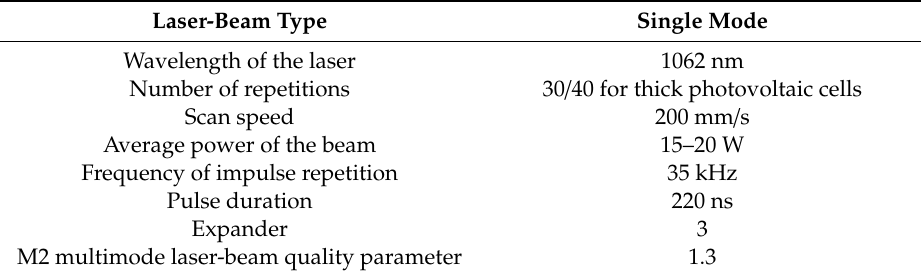
Table 2. Processing